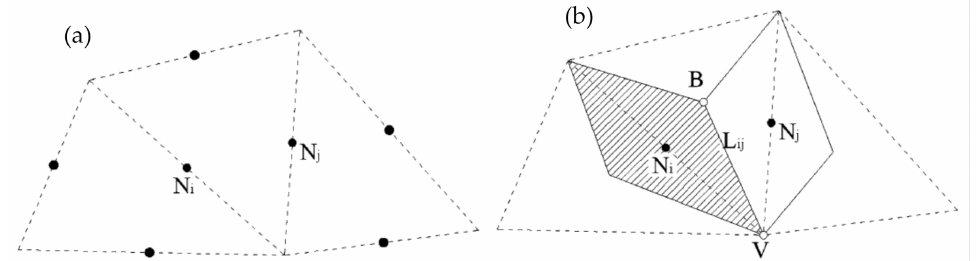
Figure 1. Finite volume cells [22]: ( a ) Initial triangle cell; ( b ) control